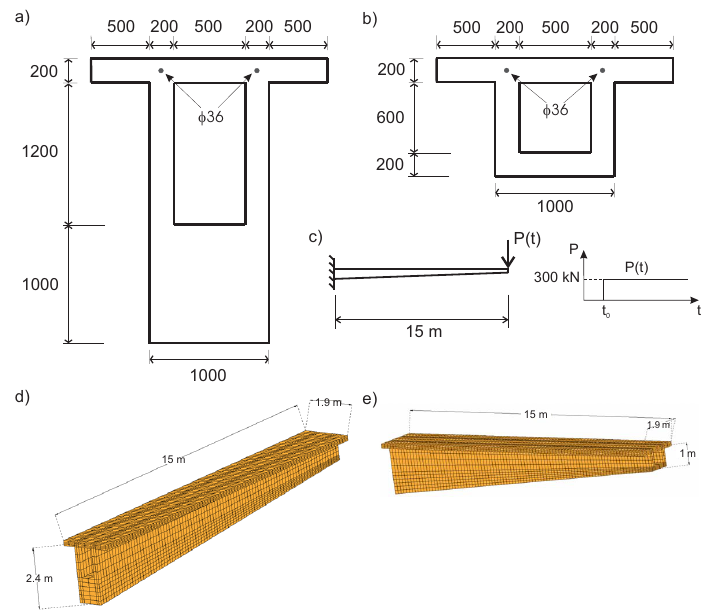
Figure 8. Cantilever prestressed concrete box girder with variable cross-section: ( a ) Cross-section geometry at the fixed end; ( b ) cross-section geometry at the free end; ( c ) boundary conditions and loading history; ( d , e ) finite element mesh. All the lengths are in millimeters.